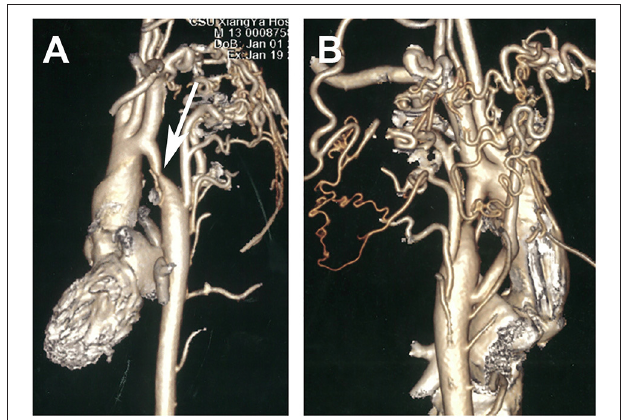
FIGURE 1 | Computed tomography angiography preoperatively showing a coarctate descending aorta [( A) , arrow] with more than eight collateral vessels between the proximal and distal coarctated tissue (B) .